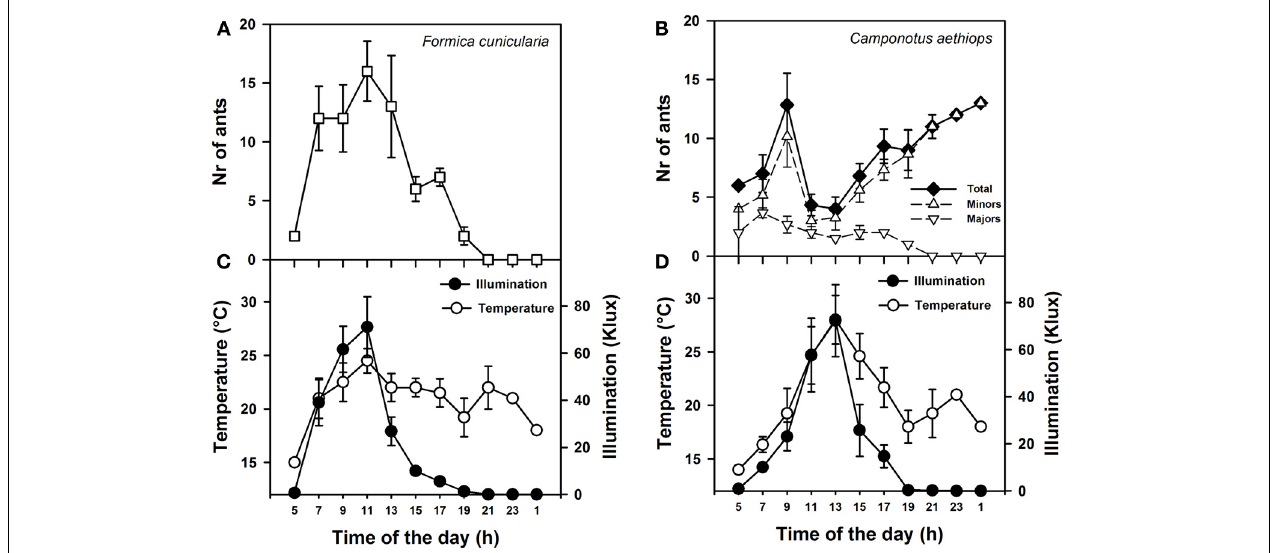
FIGURE 2 | Activity rhythms of F. cunicularia and C. aethiops as a function of environmental daylight and temperature. (A) Activity rhythm of F. Cunicularia . (B) Activity rhythms of C. aethiops majors, minors and the sum of